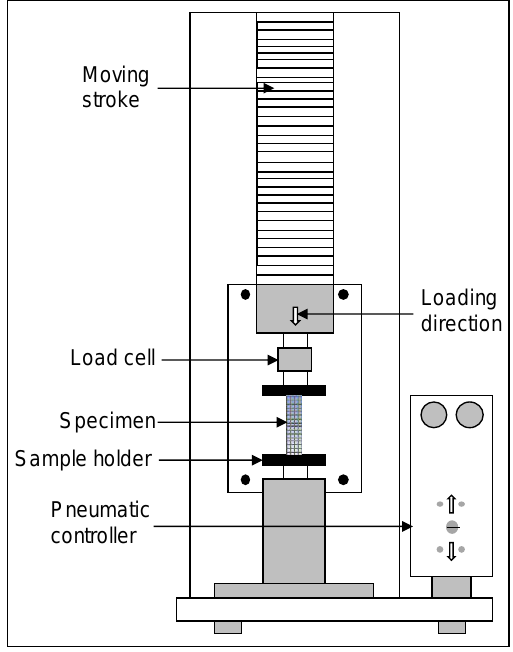
Figure 1. The Schematic diagram of the compression testing machine. The lattice structured compressive specimens were fixed in the sample holder and subjected to a displacement-controlled compressive load. Table 3. Design of experiment, parameters of samples, and results.